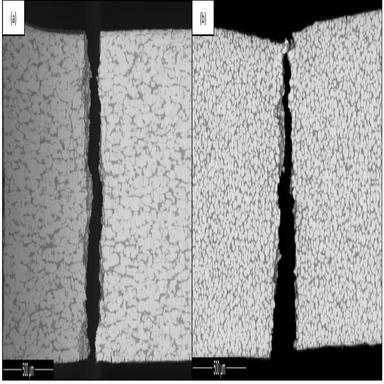
SEM backscattered electron images show the gauge region of specimens (a) R87 RD-TD and (b) AR after tensile testing, showcasing the differences in microcrack densities between processing conditions. Note the high density and even distribution of cracks across specimen (a) and the low instances of W-W cracking and localization to the fracture plane in sample (b) were observed.